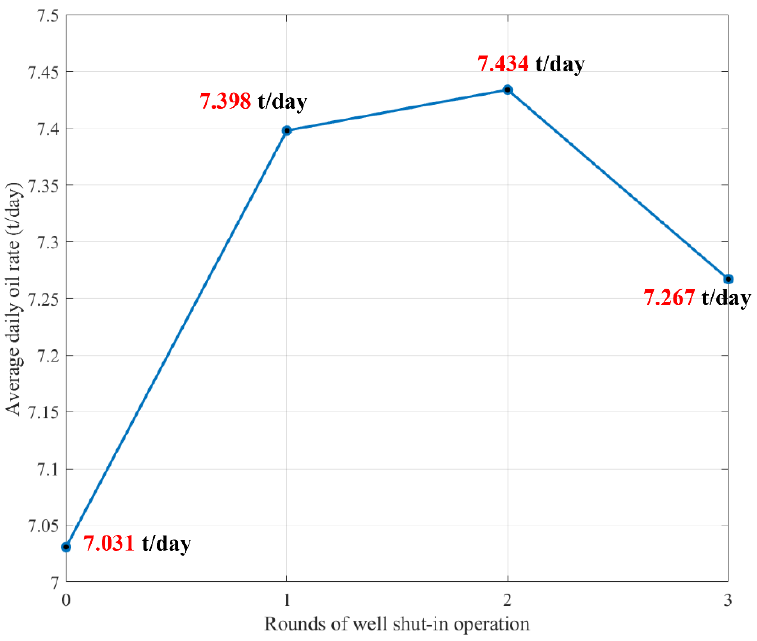
Figure 15. Average oil production rate between different rounds of shut ‐ in scenarios.